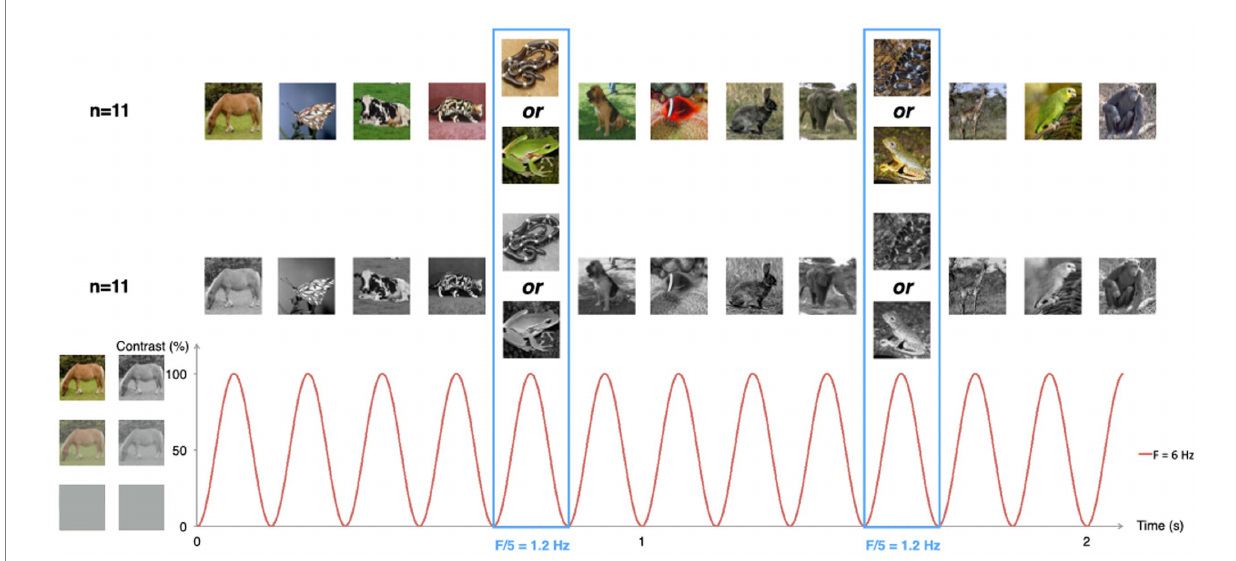
FIGURE 1 Schematic illustration of the experimental paradigm. Animal pictures were presented by sinusoidal contrast modulation at a rate of 6 per second ( F = 6 Hz). Snake or frog pictures were presented every fifth stimulus ( F = 6/5 = 1.2 Hz), in different trial sequences. Half of the infants were presented with color pictures, the other half with grayscale versions of the same